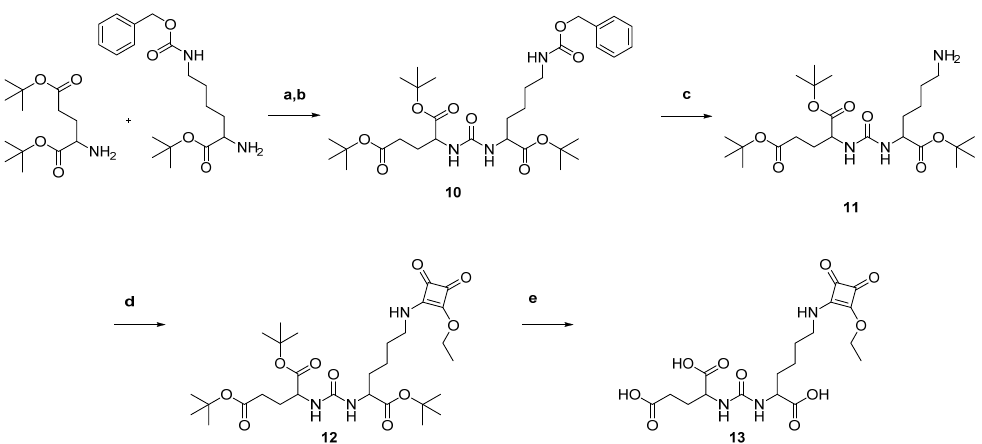
Figure 4. Synthesis of the PSMA inhibitor lysine-urea-glutamate-squaric acid monoester: (a) N( ε )- benzoyloxycarbonyl- L -lysine, triphosgene, triethylamine DCM, 0 °C; (b) L -glutamic acid di- tert -butyl ester hydrochloride, triethylamine, DCM, 41%; (c) Pd/C, MeOH, H 2 , 96%; (d) 3,4-dibutoxycyclobut-3-en-1,2-dione, 0.5 M phosphate buffer pH 7, ethyl acetate, 77%; (e) TFA/DCM, 1:1, 83%.